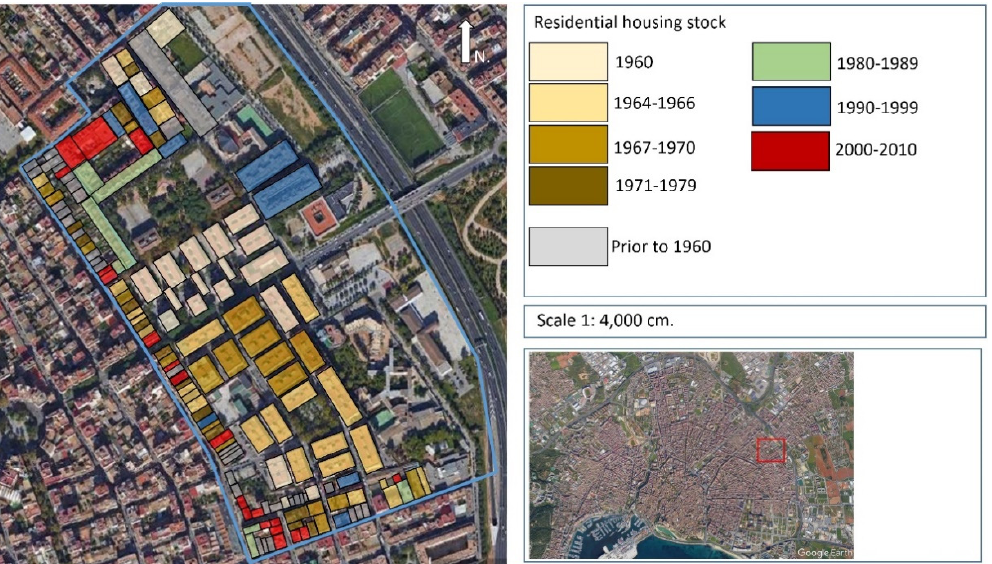
Figure 1. Age of housing stock in Son Gotleu. Source: Prepared by the author based on Land Registry website data (Cadastral Directorate General).